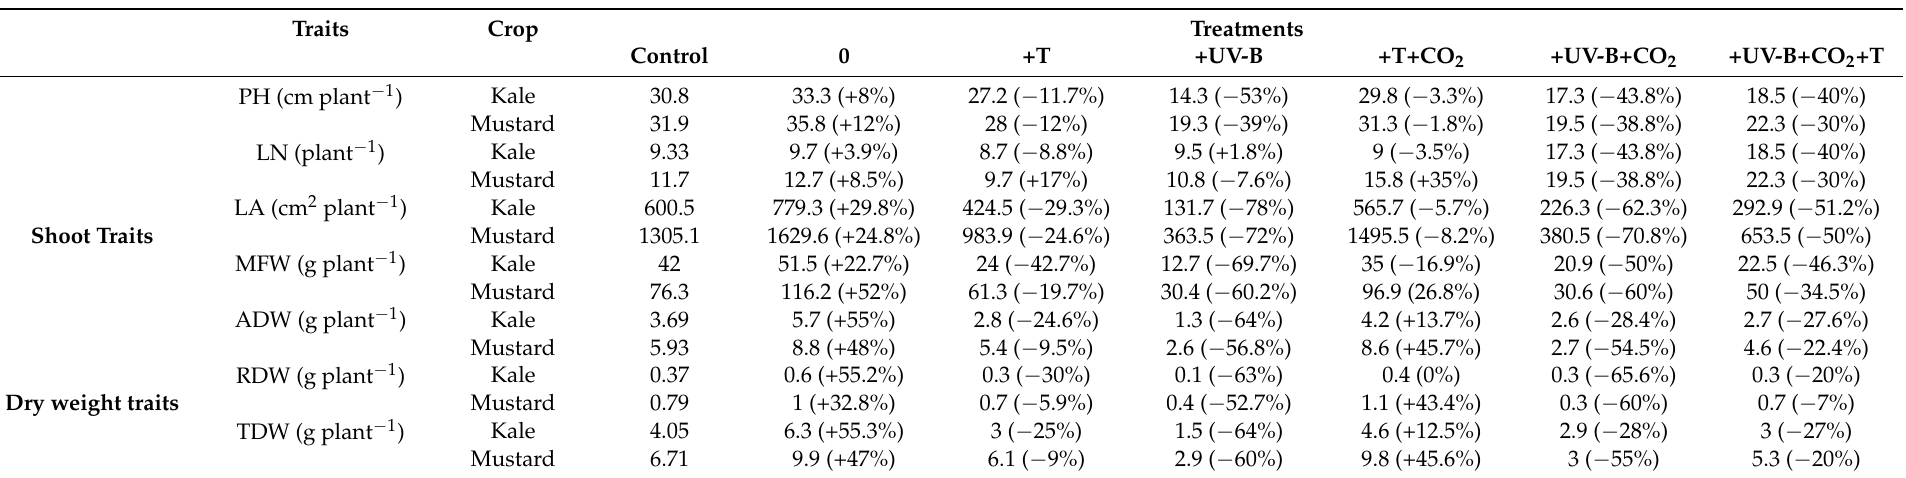
Table 3. Mean values and percent change for plant height (PH), leaf number (LN), leaf area (LA), marketable fresh weight (MFW), aboveground dry weight (ADW), root dry weight (RDW), and total dry weight (TDW) measured under CO 2 concentration (control, 400 µ mol mol − 1 and +CO 2 , 720 µ mol mol − 1 ), elevated temperatures (25/17 ◦ C and 35/27 ◦ C (day/night)), and UV-B radiation (control, 0 kJ m − 2 d − 1 , and +UV-B, 10 kJ m − 2 d − 1 ), and their interactions for kale and mustard at 26